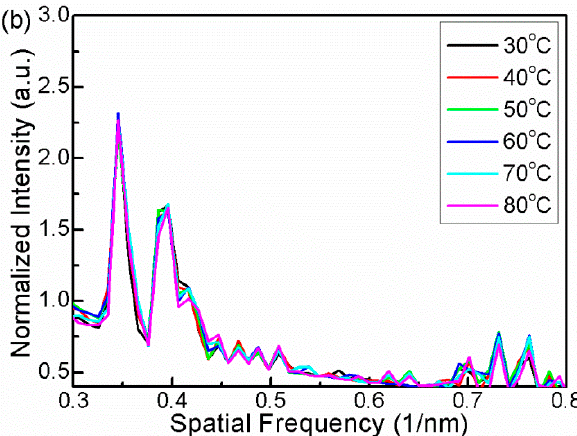
Figure 8. ( a ) FFT spectrum of the interference response to different bending angles. Insert is normalized intensity of “cladding mode 1” response to different bending angles; ( b ) FFT spectrum of the interference response to different temperatures.